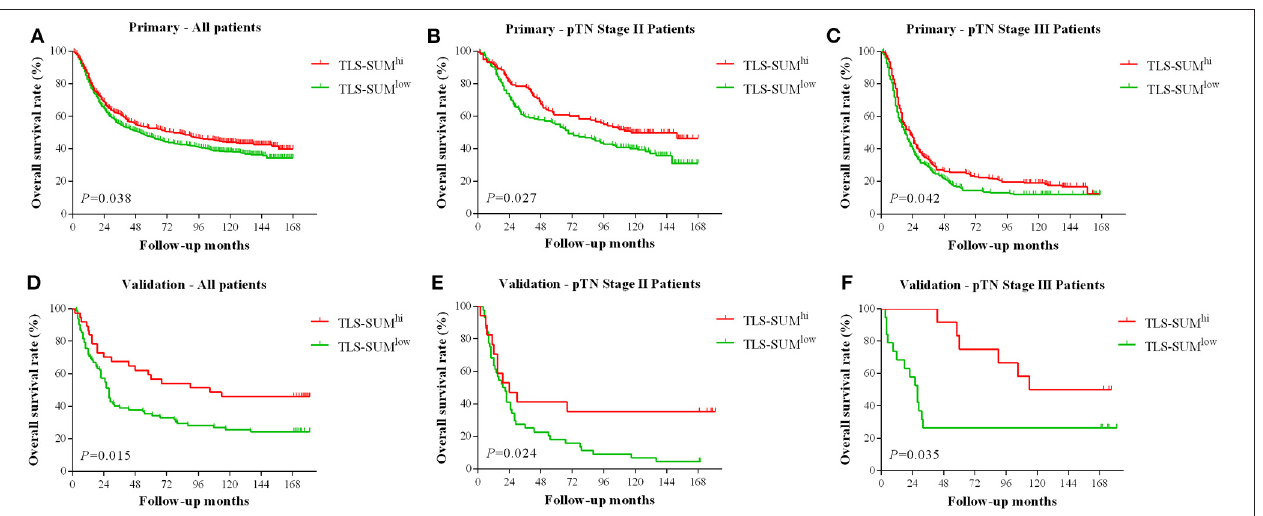
FIGURE 1 | The hierarchical Kaplan–Meier survival curves for TLS-SUM in GC. TLS-SUM hi is associated with better prognosis in GC patients from the primary cohort (A) and the validation cohort (D) . The contribution of TLS to the prognostic power of pTN stages II and III patients was evaluated from the primary cohort (B,C) and the validation cohort (E,F) . TLS, tertiary lymphoid structure; GC, gastric